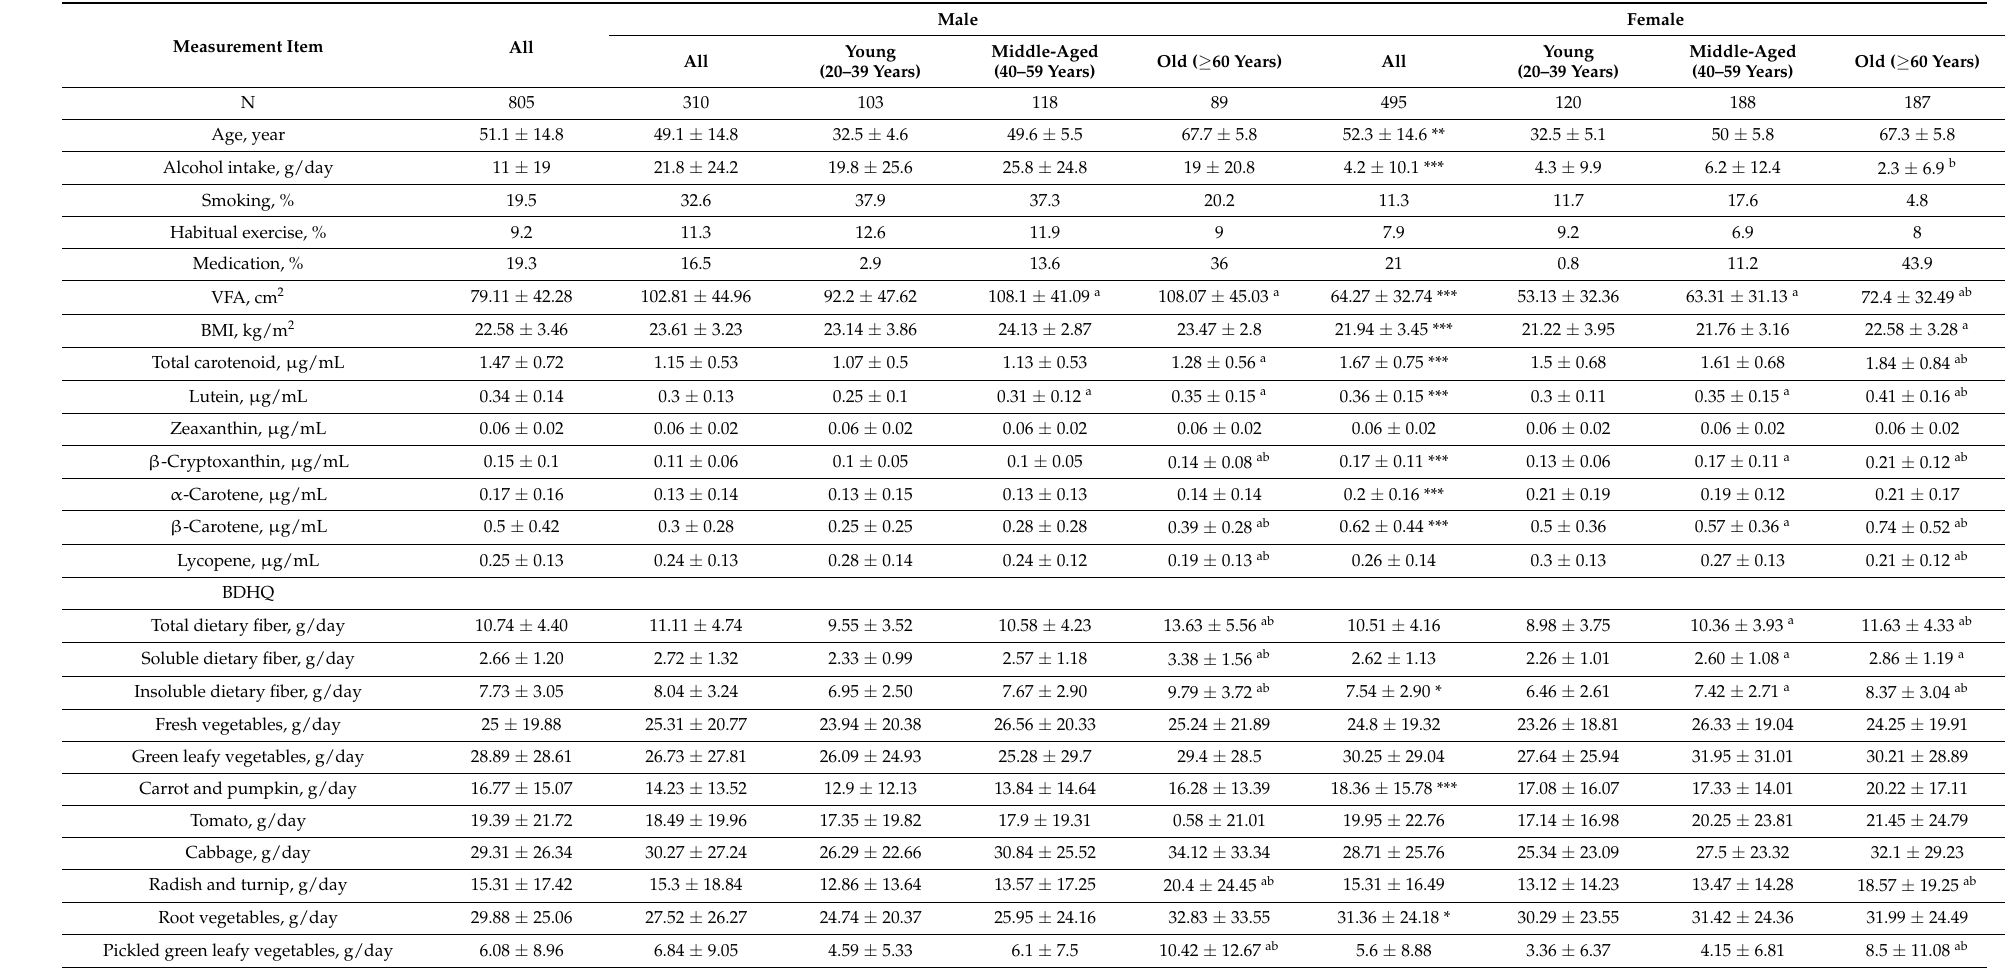
Table 1. Characteristics of the study